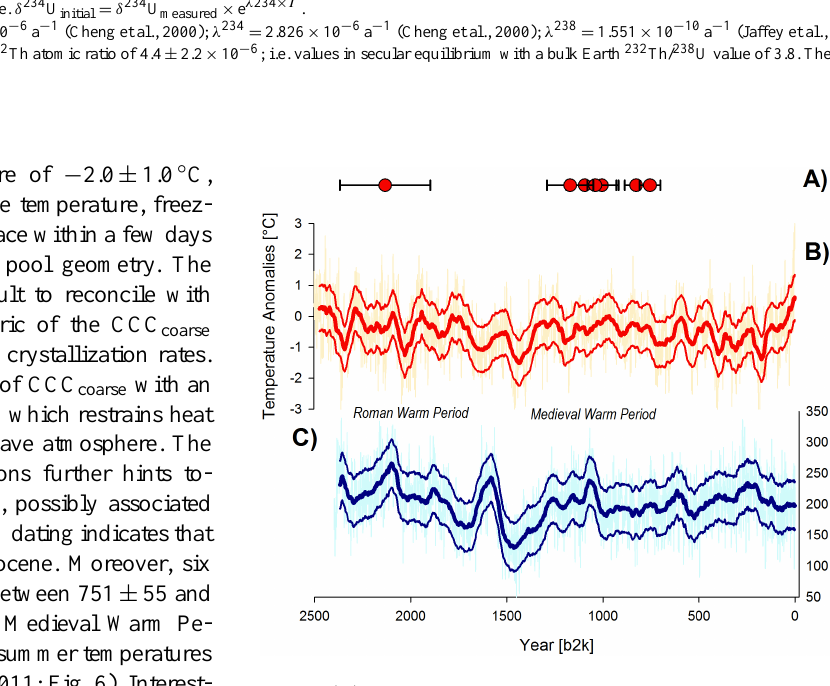
carbonate saturation of the parent water and the associated freezing rate, a variety of CCC coarse may be expected, under- lined by their geochemical